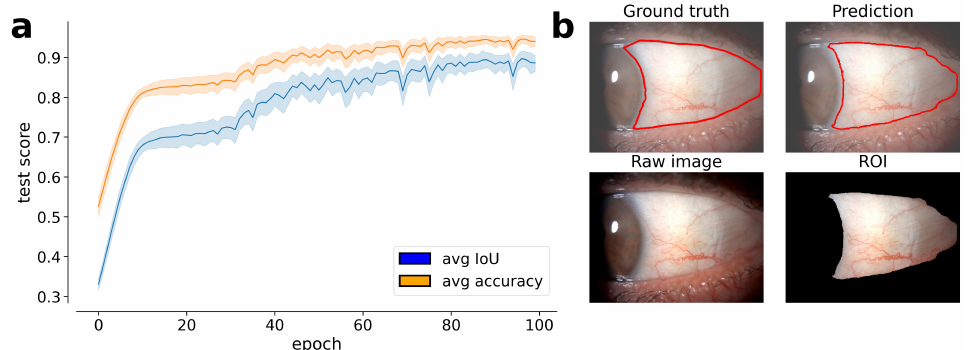
Figure 2. Results obtained by the trained Mobile U-Net model on the 18 test images. ( a ) evolution of the average accuracy and average IoU along the training epochs (100). The IoU score is more informative given that it is robust to unbalances in the sample, differently from the accuracy score; ( b ) example of the results obtained on a test image. On the top-left, the ground truth. On the top-right, the predicted segmentation. On the bottom-left, the raw (input) image. On the bottom-right, the resulting ROI of the conjunctival